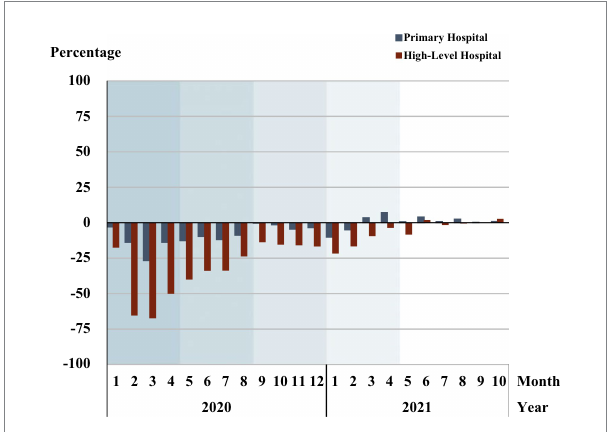
FIGURE 5 Percentage change of outpatients in primary and high-level hospitals. Each shadow area denotes COVID-19 phase 1 to phase 5.